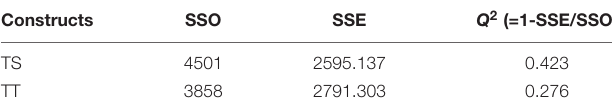
TABLE 6 | Cross validity redundancy